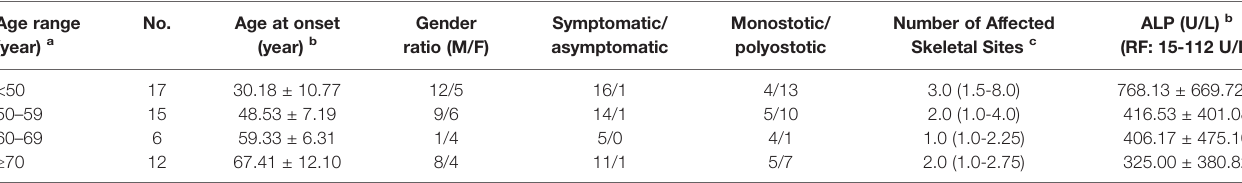
TABLE 4 | Age-speci fi c clinical features and biochemical pro fi le of PDB in